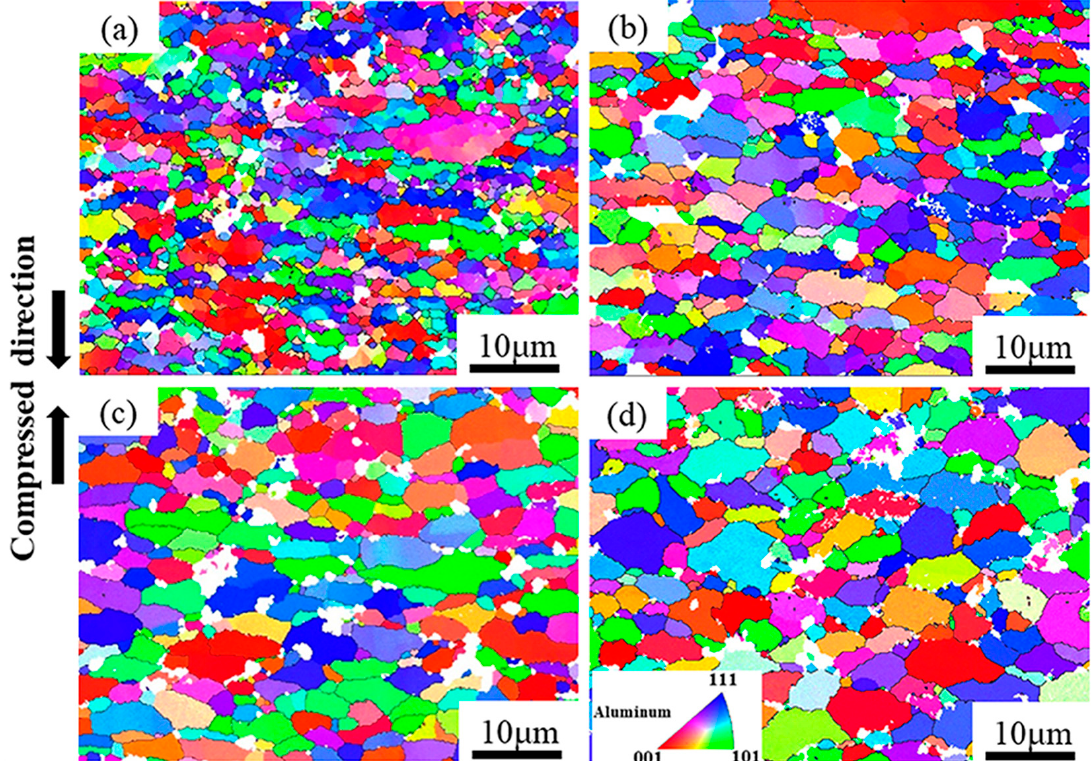
Figure 6. The inverse pole figures (IPF) maps of PM composites under different Z values: ( a ) lnZ = 30.0 (300 °C/1 s − 1 ), ( b ) lnZ = 25.8 (340 °C /0.1 s − 1 ), ( c ) lnZ = 21.7 (380 °C/0.01 s − 1 ), ( d ) lnZ = 16.6 (460 °C / 0.001 s − 1 ) (HAGBs are in black lines).